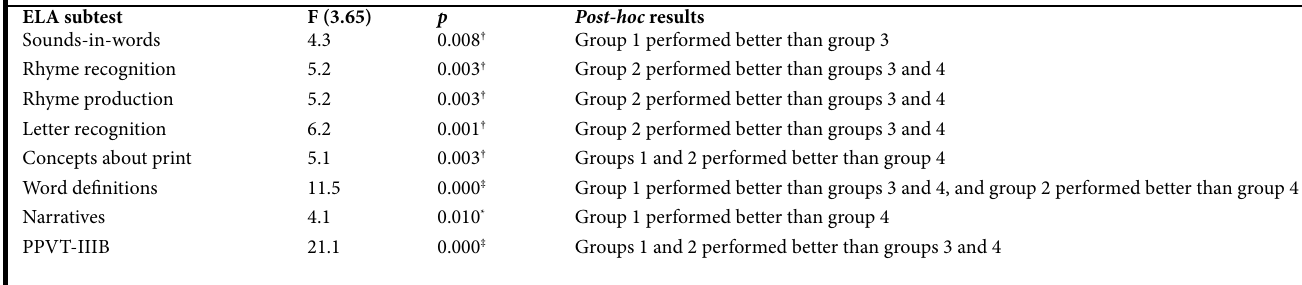
table v. Significant differences in performance on ELA subtests post intervention ( p <0.05 * , p <0.01 † , p <0.001 ‡